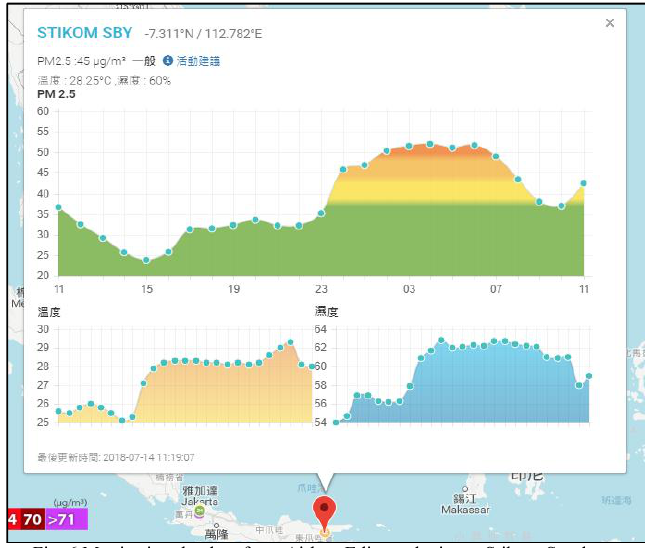
Fig. 6 Monitoring the data from Airbox Edimax device at Stikom Surabaya The study collected data from seven days of observation. The data were grouped by the date and then summarized using descriptive statistics (minimum, maximum, and average value).